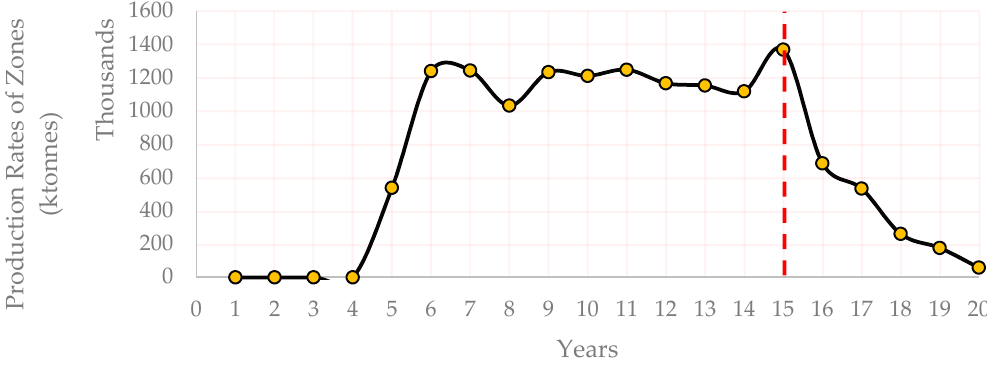
Figure 4. Mine overall production schedule.